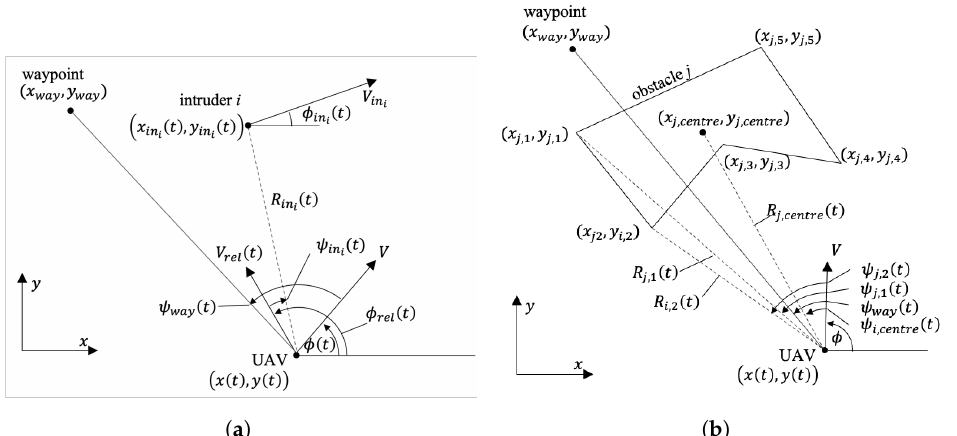
Figure 1. Relative geometries of a UAV. ( a ) Relative geometry to a moving intruder. ( b ) Relative geometry to a polygonal